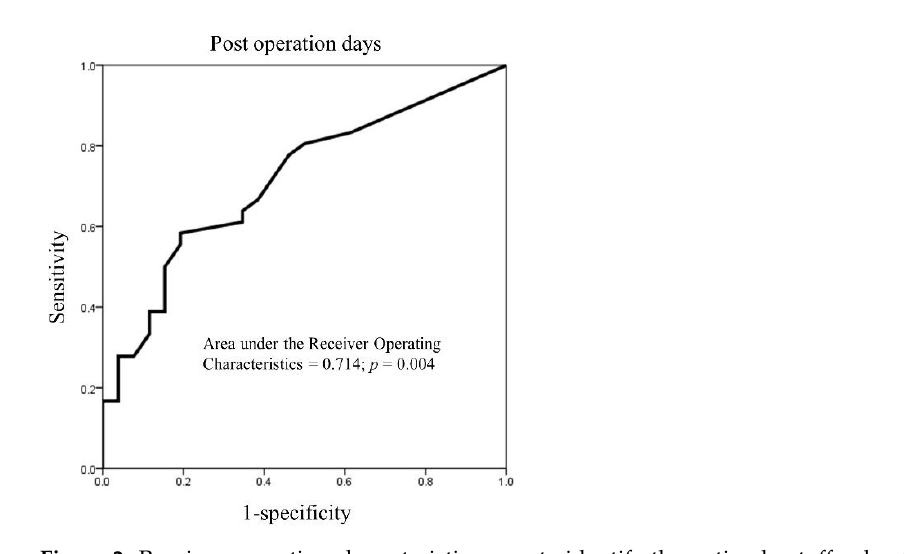
Figure 2. Receiver operating characteristic curve to identify the optimal cutoff value for the time interval from surgery to pleural effusion drainage using liberation from mechanical ventilation within the first 72 post-procedural hours as the outcome of interest.